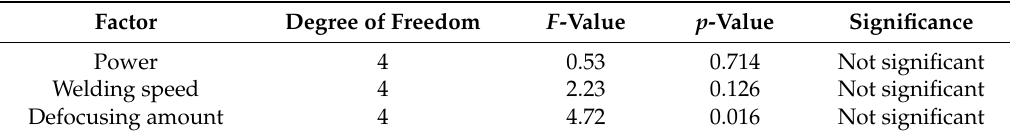
Table 3. Analysis of variance results of orthogonal